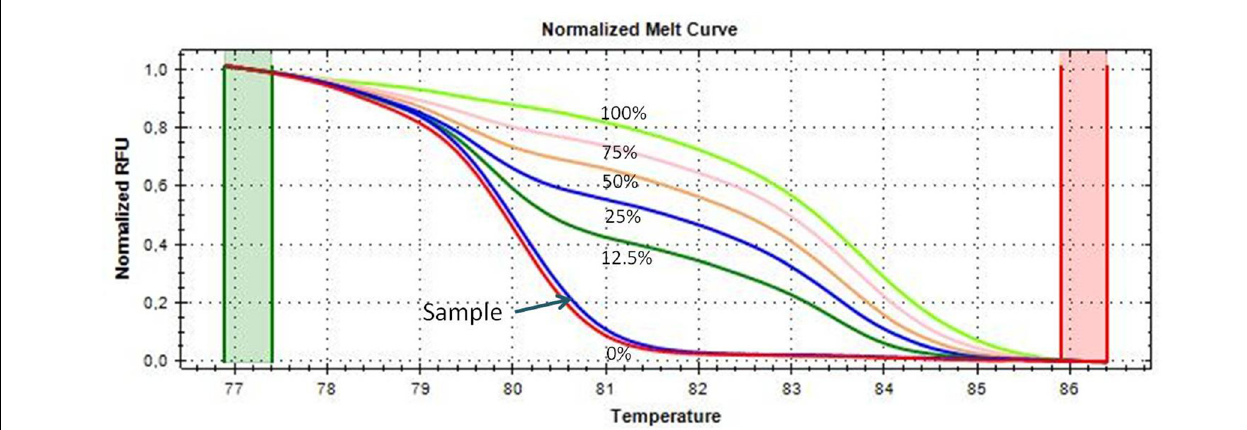
FIGURE 1 | Melting curves of the CDKN2A gene generated by samples with known methylation levels (0, 12.5, 25, 50, 75, and 100% methylation, respectively), obtained by mixing the fully methylated and unmethylated standard DNA samples. A thymoma sample showing almost 0% promoter methylation is shown and indicated with an arrow; its melting curve is very similar and partially juxtaposed to that of the completely unmethylated standard DNA (red